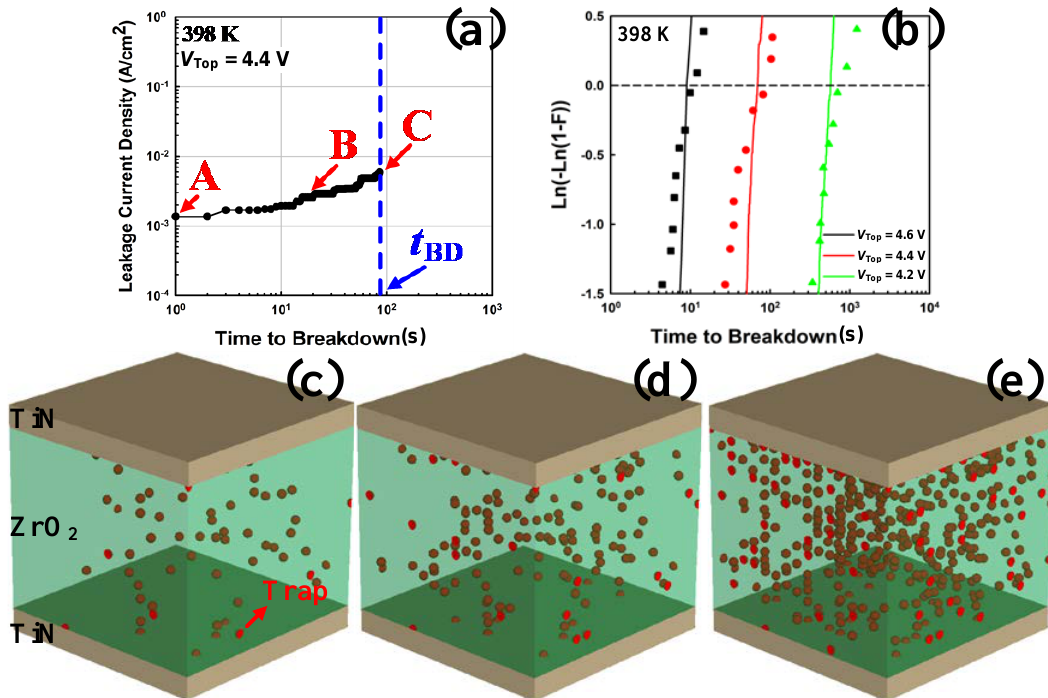
Figure 4. TDDB simulation with a constant voltage stress of 4.4 V at 398 K. ( a ) Leakage current density until the TDDB. ( b ) Weibull plot for the experimental (symbols) and simulation (lines) results. ( c )–( e ) represent points A–C in ( a ), respectively. The red spheres indicate trap sites. Trap generation according to the stress and ( e ) formation of a percolation path were observed.